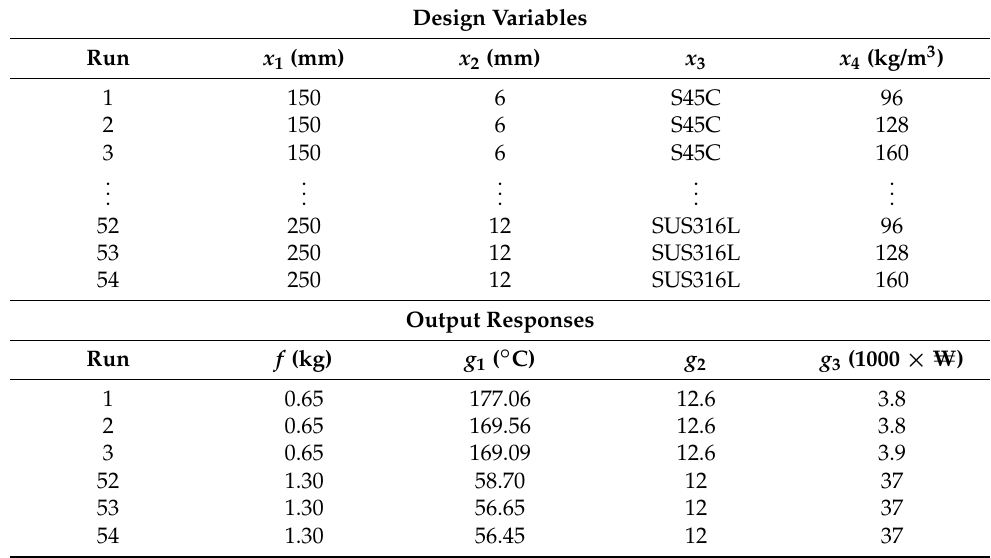
Table 4. Design variables and their levels.